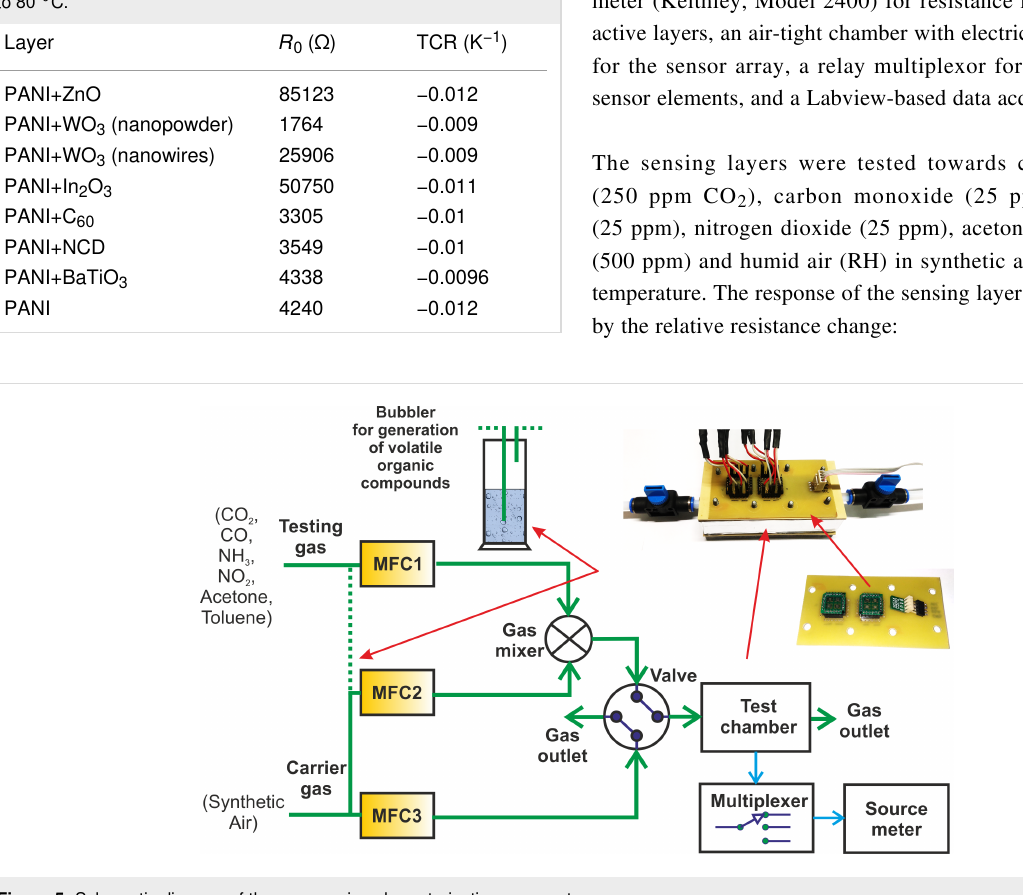
Figure 5: Schematic diagram of the gas sensing characterizations apparatus.